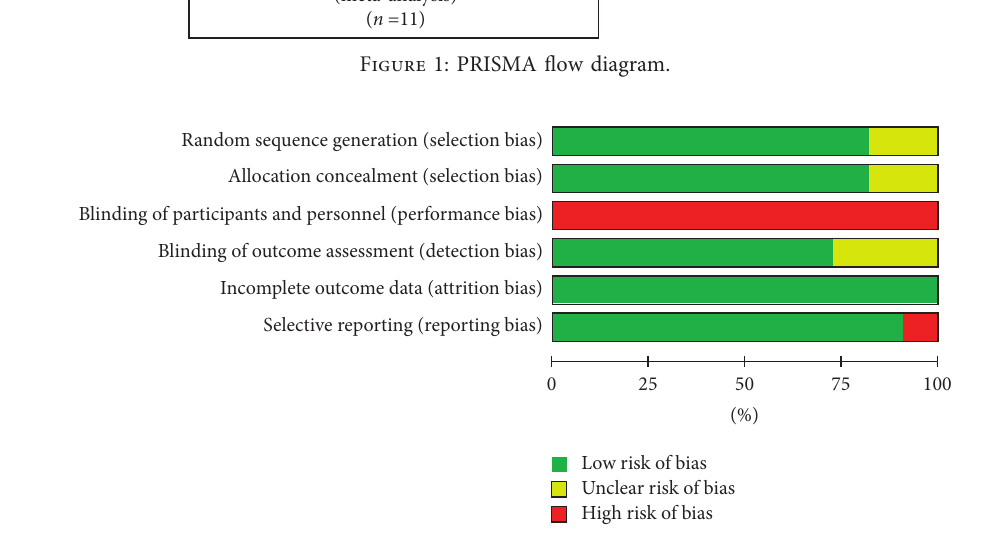
Figure 2: Summary risk of bias of included